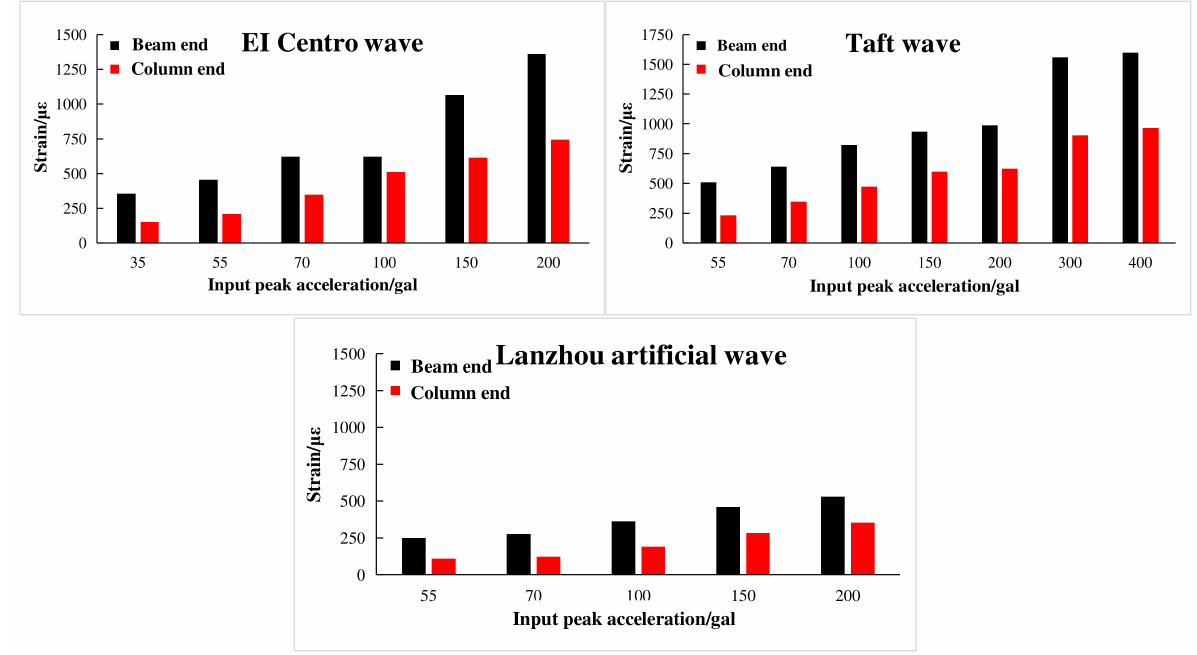
Figure 21. Peak strain at beam end and column end of composite